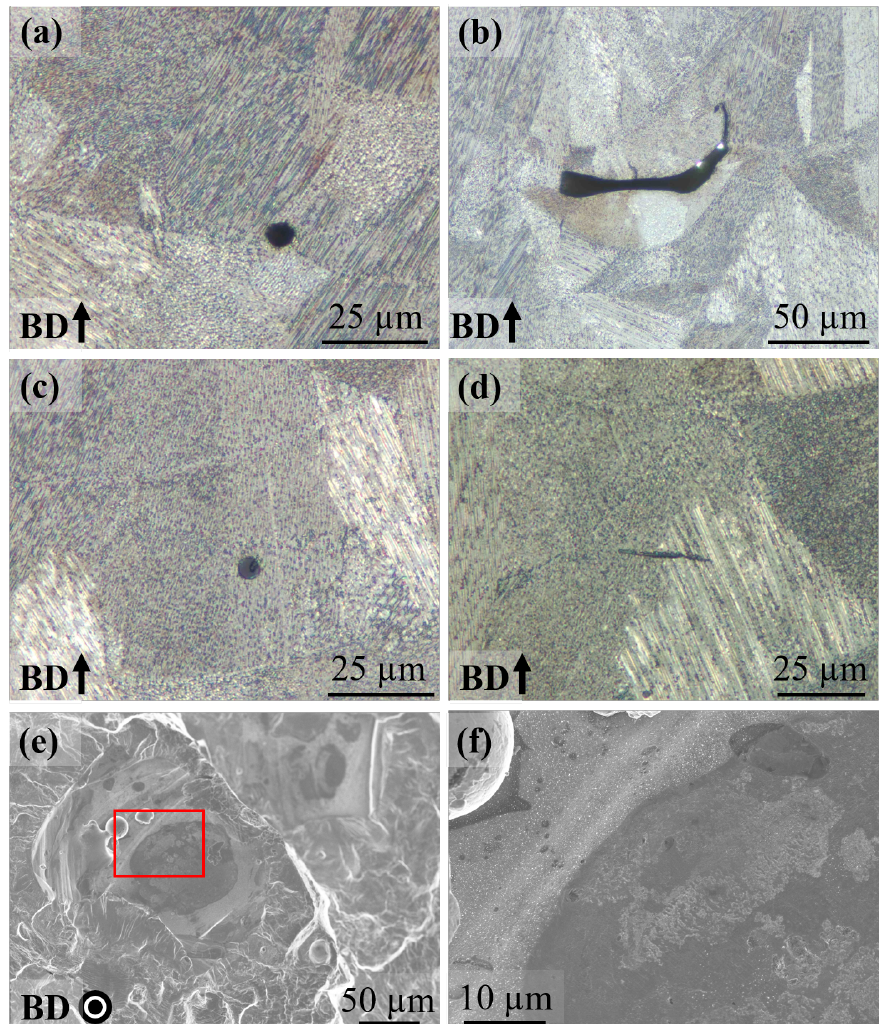
Figure 9. Defects in AB condition. ( a ) Porosity ( b ) LoF ( c , d ) inclusions ( e ) LoF from a fracture surface ( f ) magnified image of area indicated in ( e